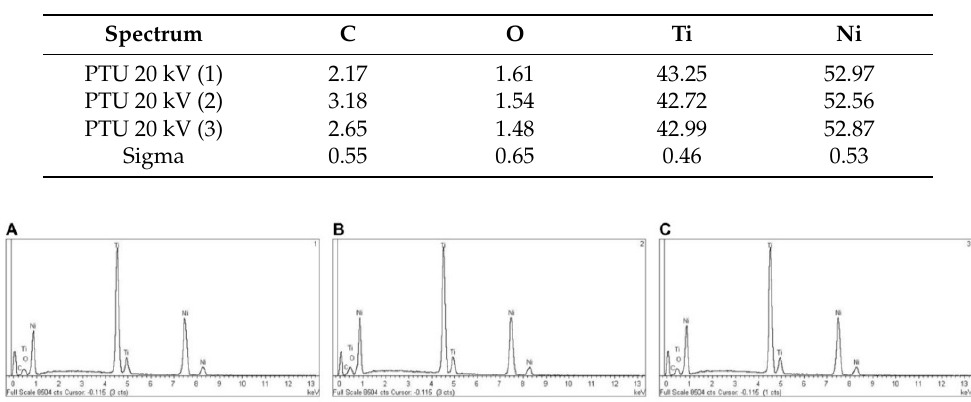
Figure 8. EDX micro-analysis of NiTi alloy PTU endodontic rotary files in location ( A ) 1, ( B ) 2, and ( C ) 3.